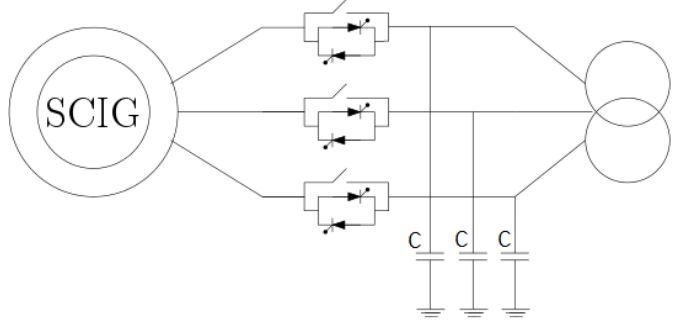
Figure 19. A squirrel-cage induction generator with the required soft starters and the capacitor